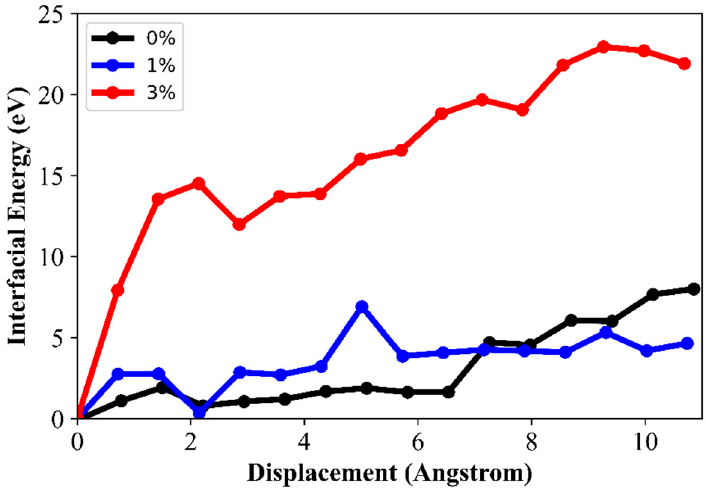
Figure 6. Averaged interfacial energy of four models of nano-engineered carbon fibers for each single-walled carbon nanotube loading percentage as a function of displacement in the z-direction from the twenty atactic 40-monomer polypropylene chains.